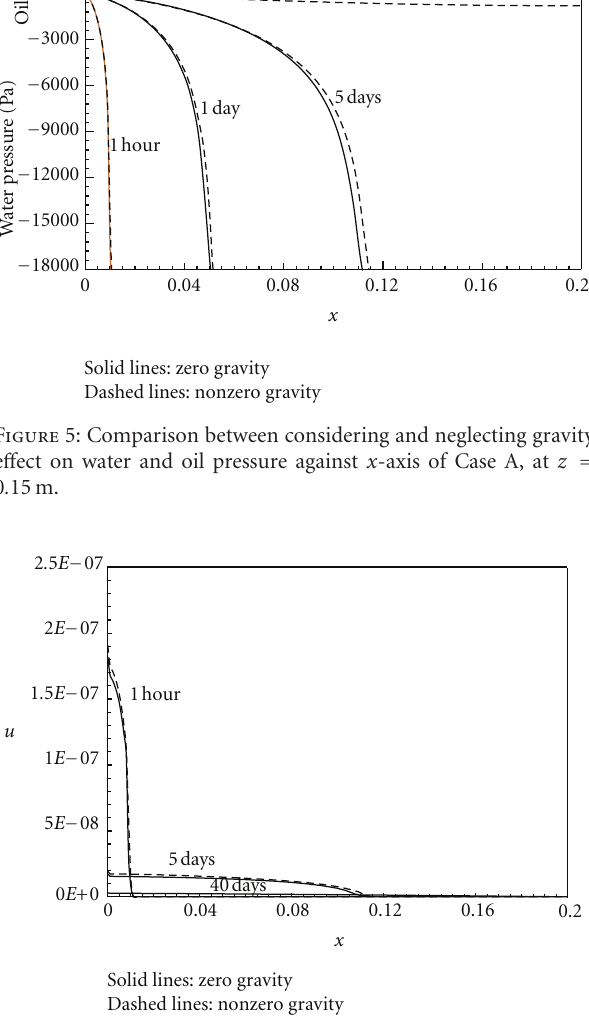
Solid lines: zero gravity Dashed lines: nonzero gravity Figure 8: Comparison between considering and neglecting gravity e ff ect on water and oil pressure against z -axis of Case B, at x = 0 . 15